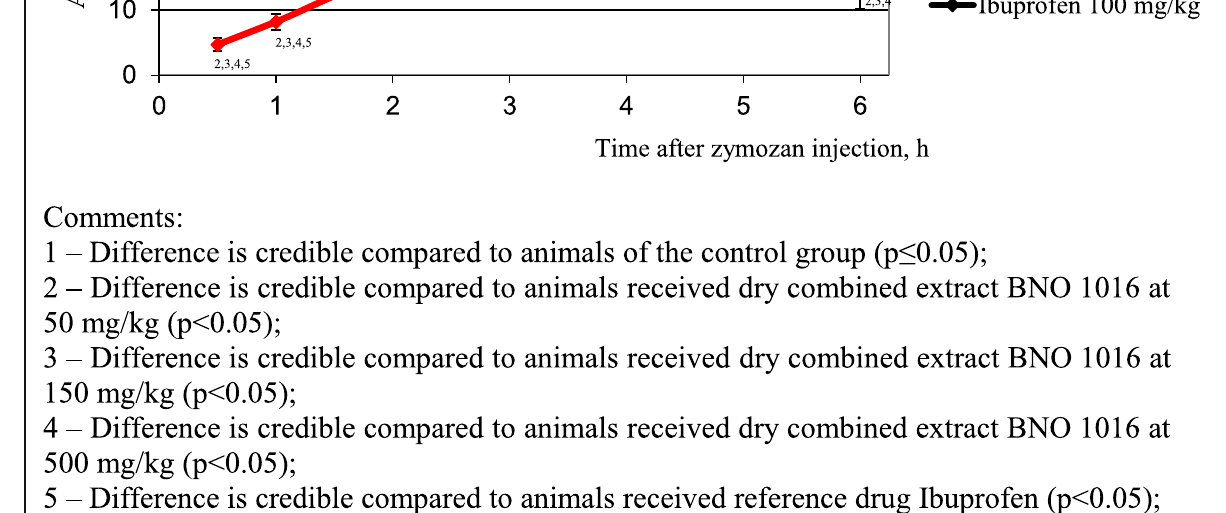
Fig. 2 Anti-inflammatory activity of dry combined extract BNO 1016